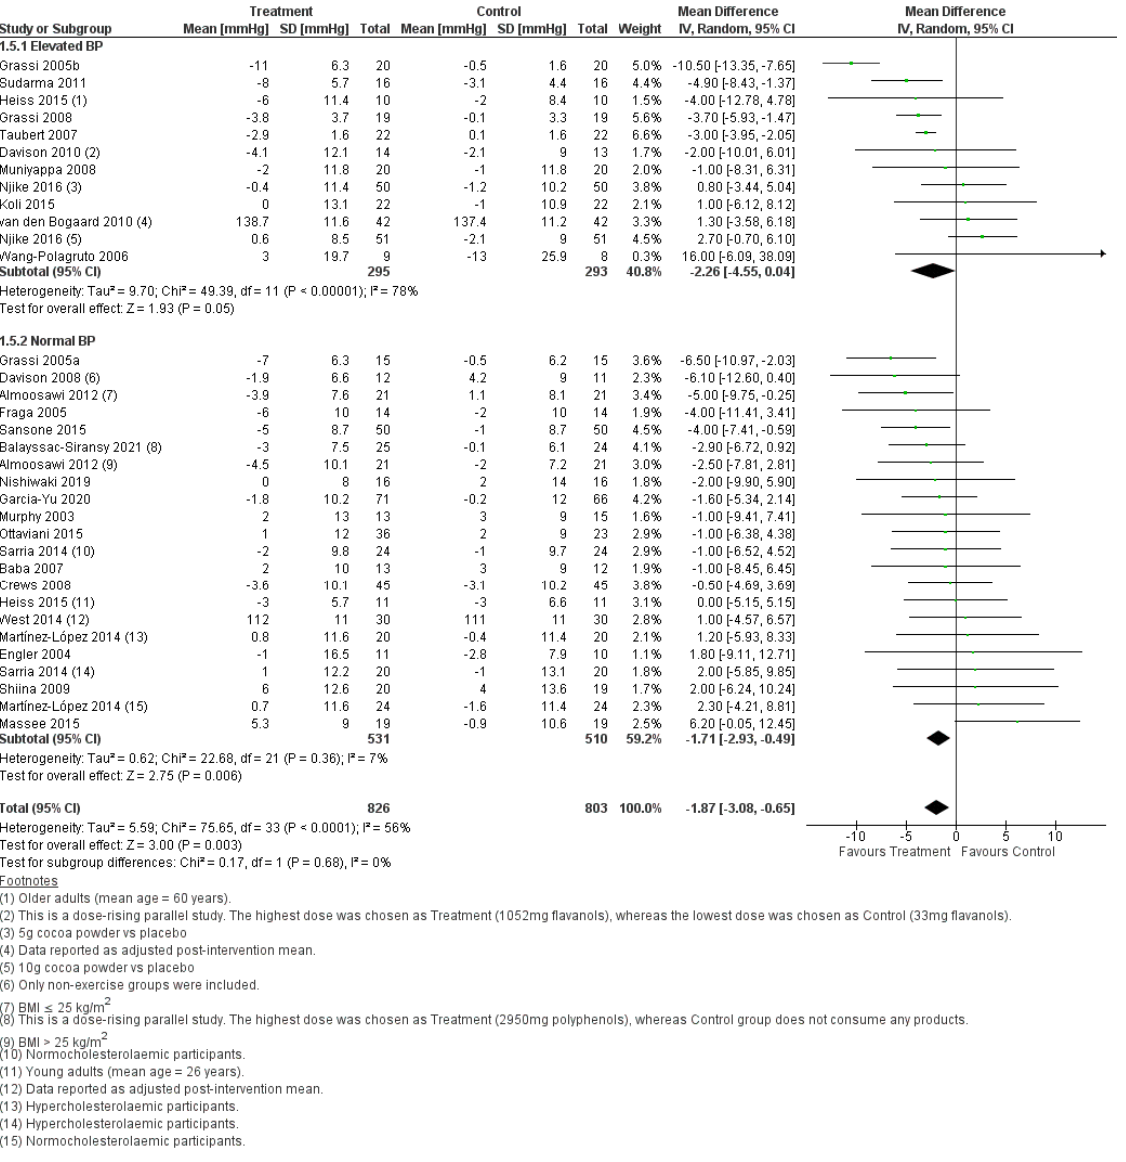
Figure 4. Forest plot showing the pooled effect of cocoa consumption on resting systolic BP.